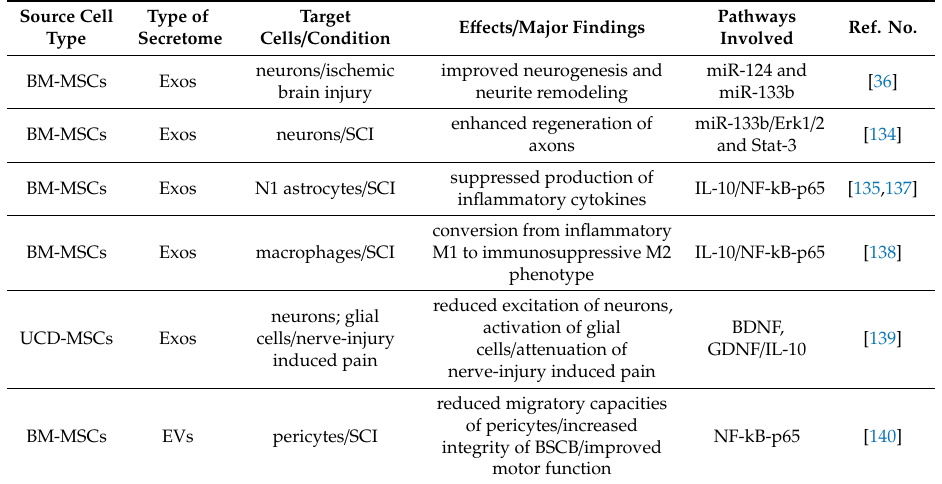
Table 7. MSC-derived secretomes in the therapy of ischemic brain damage and spinal cord injury. Source Cell Type of Target E ff ects / Major Findings Type Secretome Cells / Condition